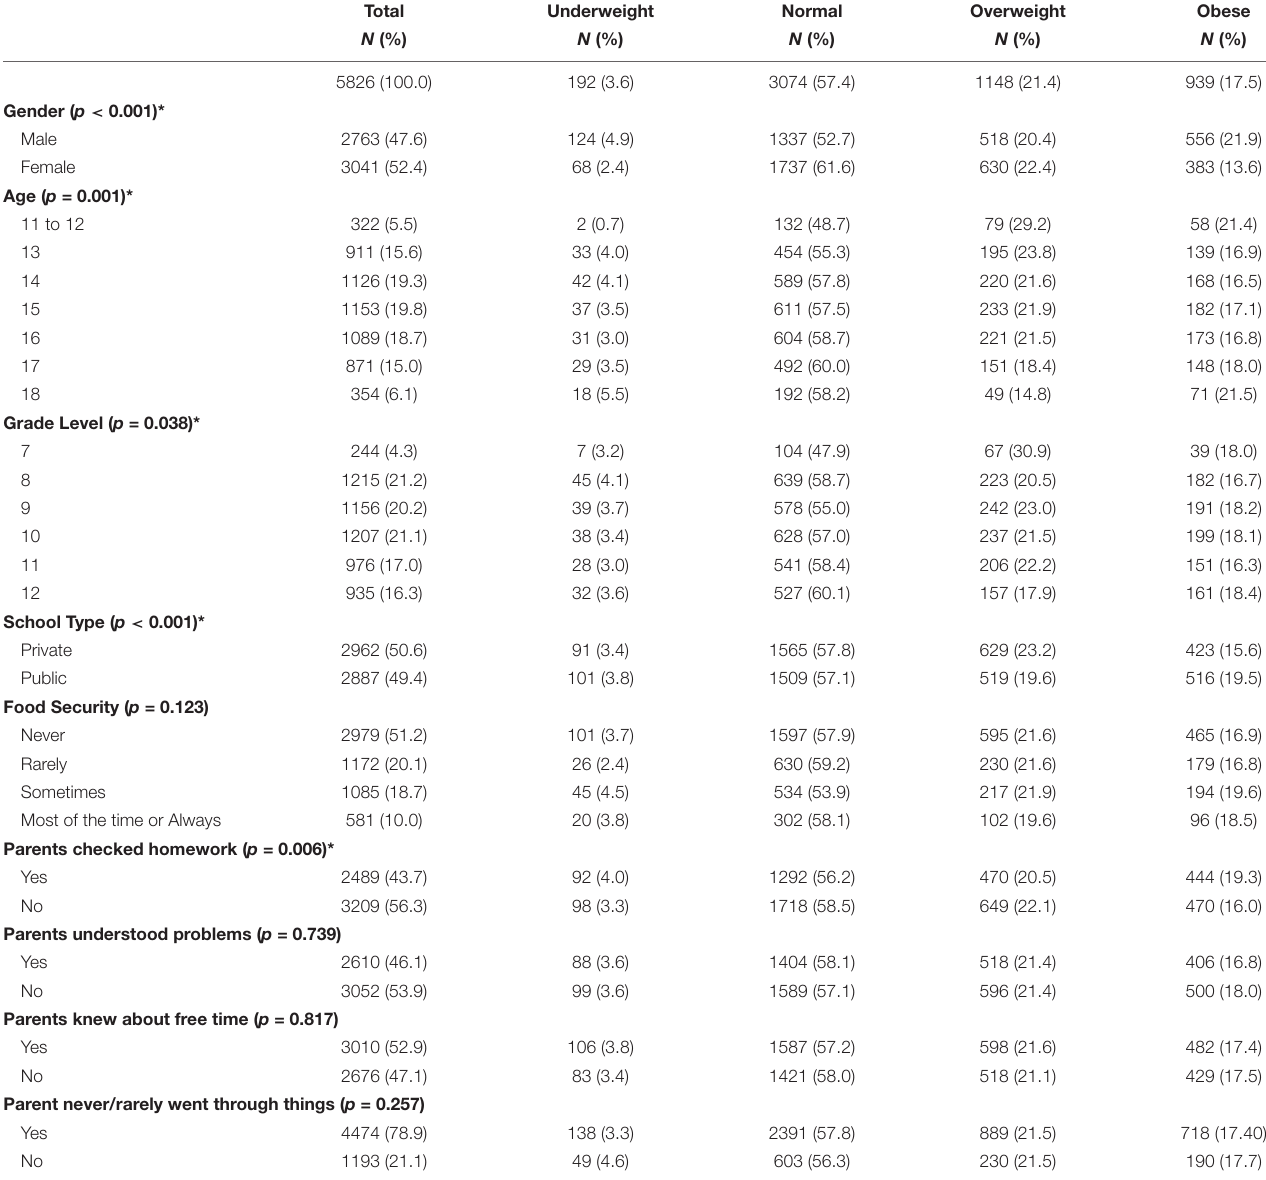
TABLE 1 | Participant demographics and association with weight category. Total Underweight Normal